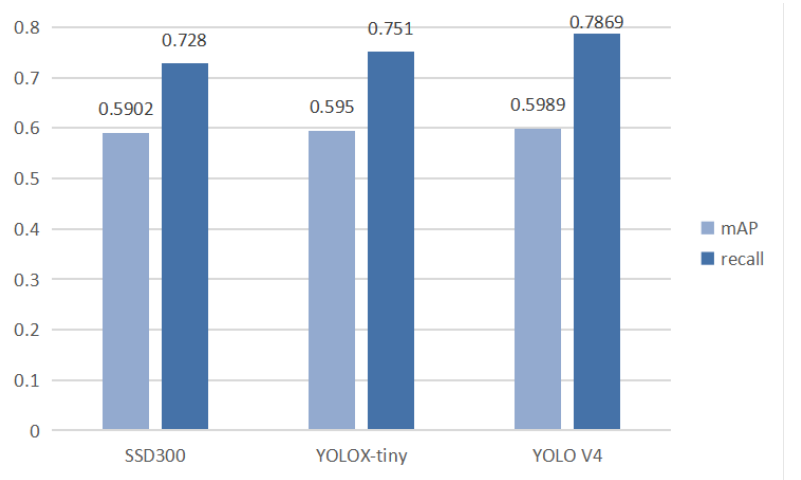
Figure 8. Detection performance comparison results.